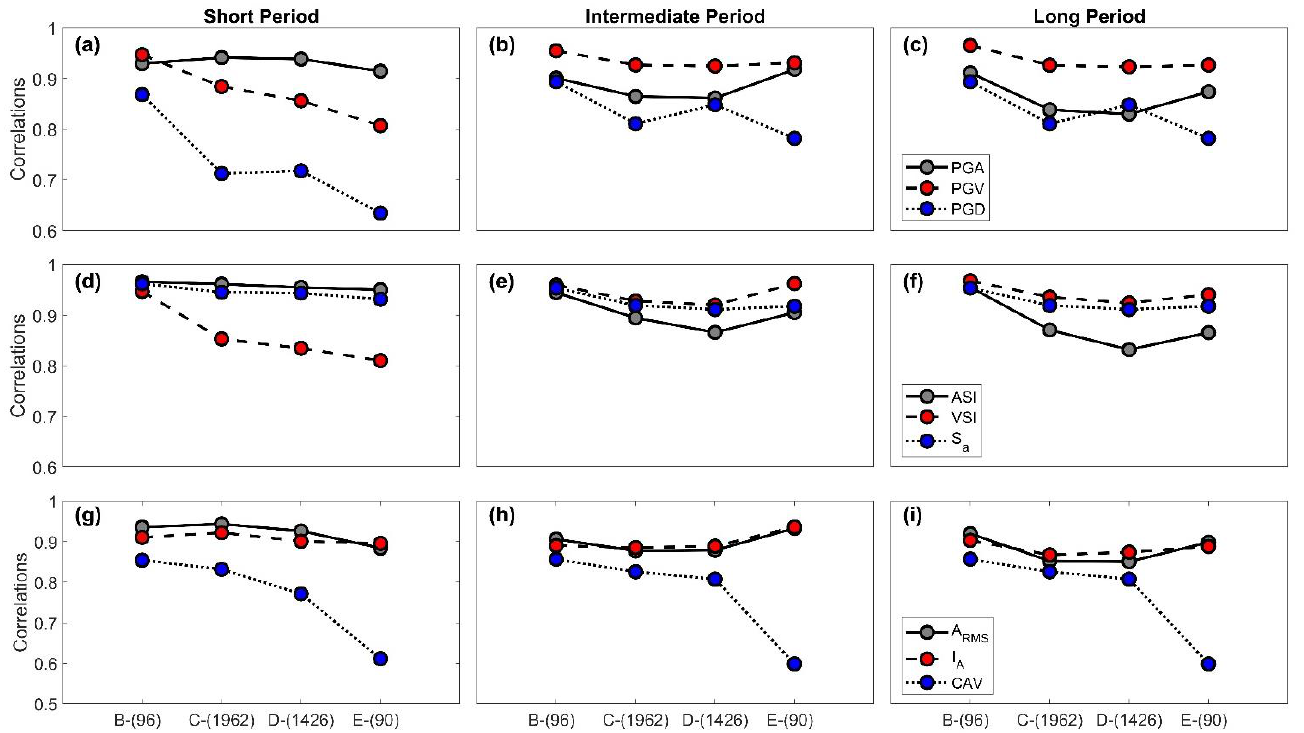
Figure 11. Dependence of correlations of intensity measures with site classes B, C, D and E (based on NEHRP recommendation), along with number of records per site class (in brackets). Rows represent variations in correlations of peak measures, spectral measures and energy measures for three different types of structures (SP, IP, LP). For short-period structures, the correlations of PGA appear to be independent of site class ( a ). For IP/LP structures, correlations of PGV are invariant with site class ( b , c ). PGD correlations decrease with site class ( c ). For spectral measures, ASI and VSI exhibit correlations similar to PGA and PGV ( d – f ). For energy measures, A RMS and I A show good correlations and least dependence with site class ( g – i ).